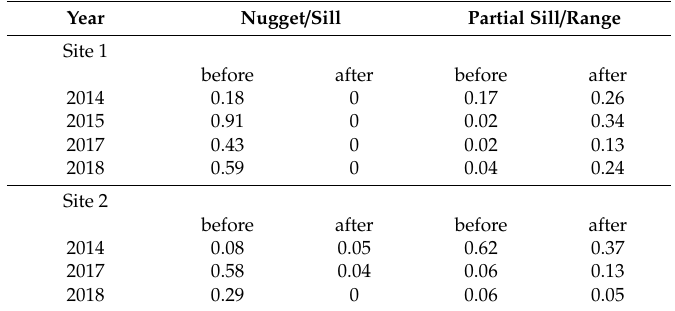
Table 3. Variogram statistics of yield monitor data values before and after-spatial filtering.